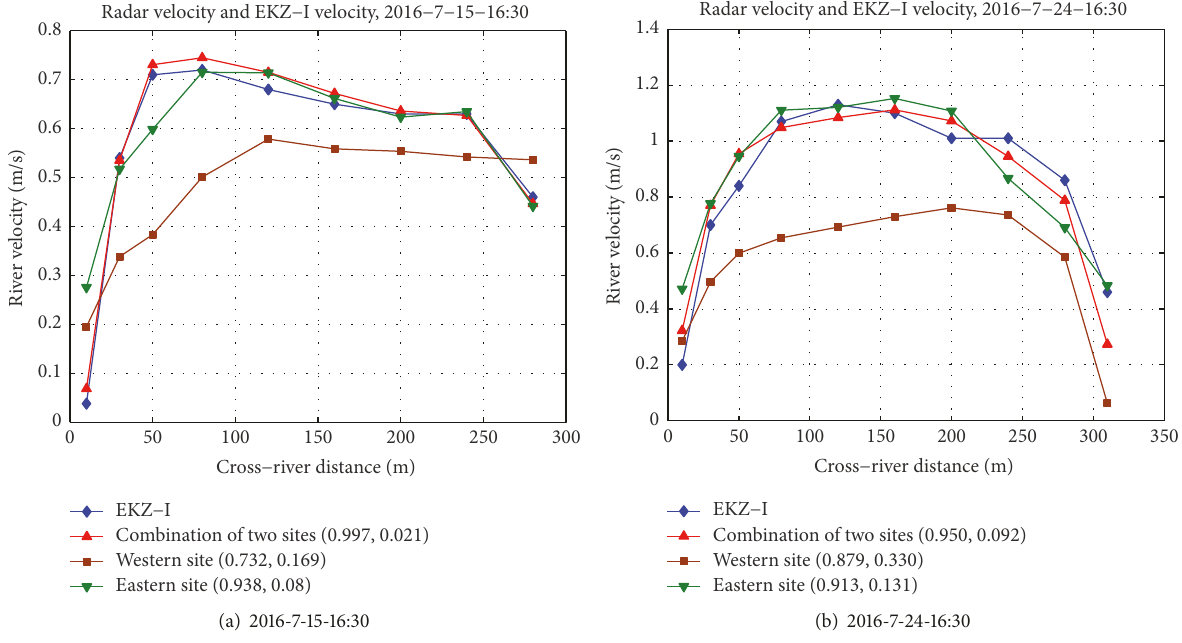
Figure 14: The comparison of the results between OSMAR-SU and EKZ-I.